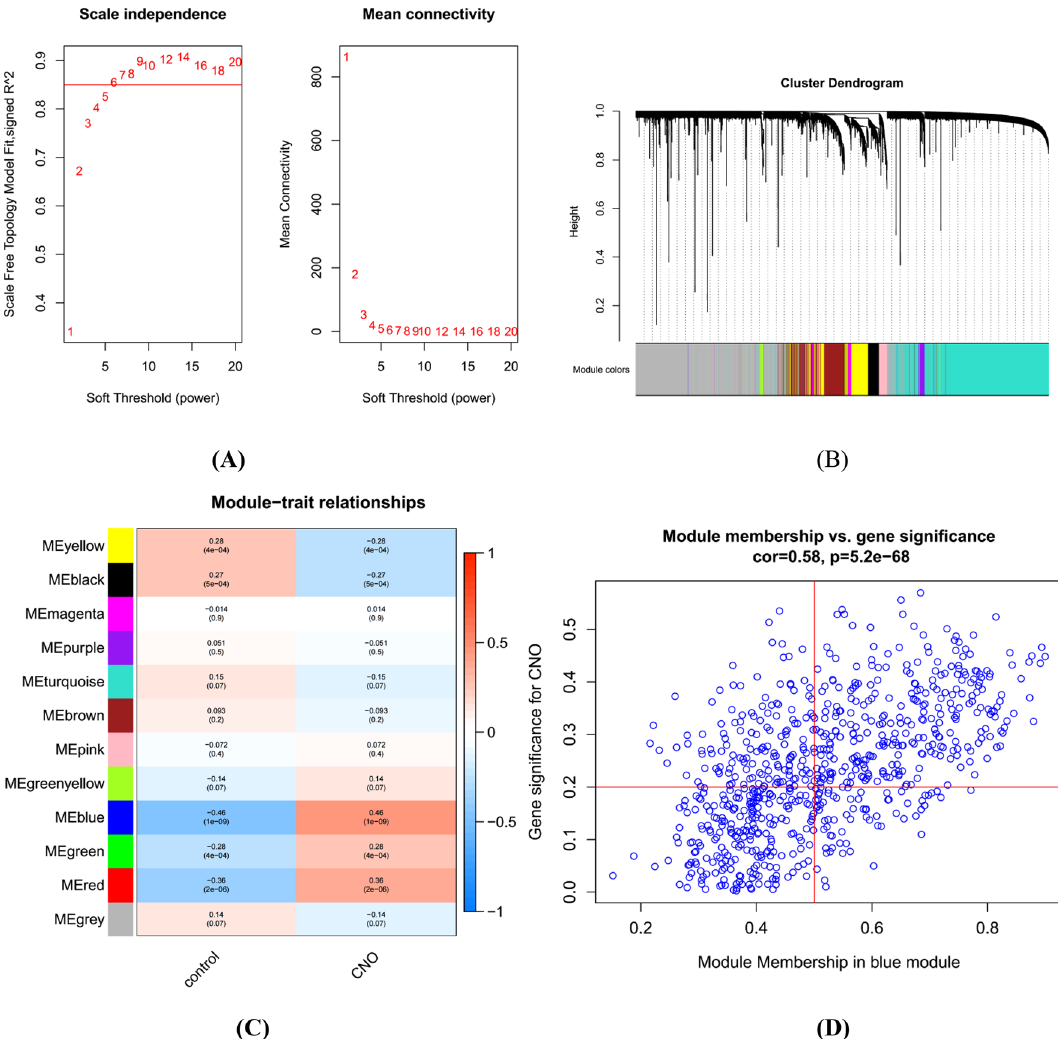
Figure 2. Weighted gene coexpression network analysis (WGCNA). ( A ) Network topology analysis under various soft-threshold powers. Left: Analysis of the scale-free index for various soft-threshold powers (β). Right: Analysis of the mean connectivity for various soft-threshold powers. ( B ) Identification of coexpressed gene modules. The branches of the dendrogram cluster into eleven modules, and each module is labelled in a unique colour. ( C ) A heatmap showing the correlation between each module eigengene and phenotype. ( D ) The relevance of members in the blue module to CNO. GS: Correlation of all gene expression profiles with module genes. MM: Absolute values of correlations between genes and phenotypic